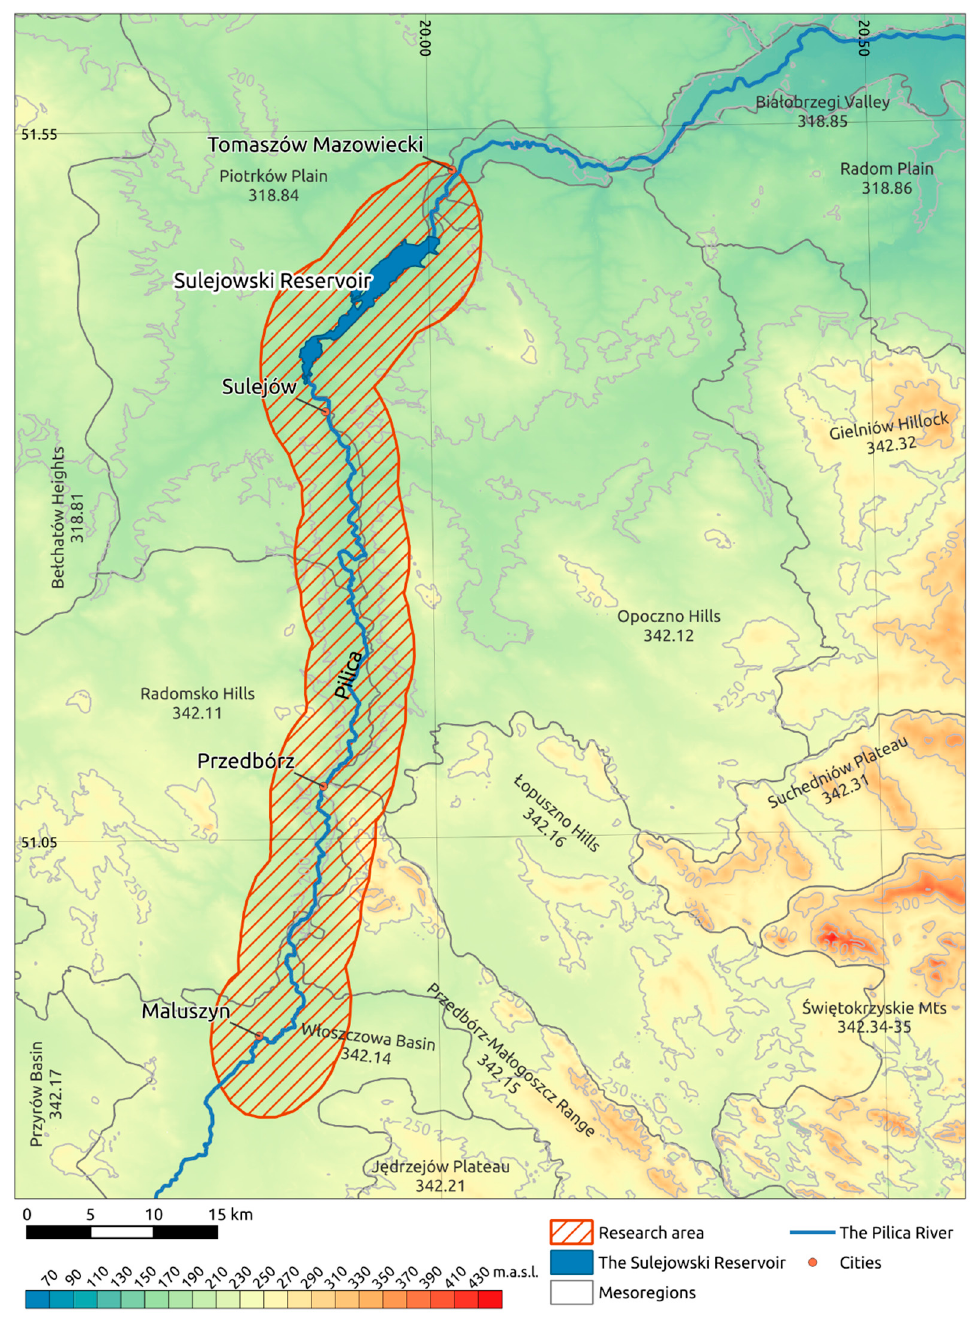
Figure 2. Research area, source: own elaboration based on physico-geographical regionalization of Poland [13] and Head Office of Geodesy and Cartography data [40]. Mesoregions codes are consistent with those introduced in the referenced paper and therefore enable precise localization of the research area within Polish mesoregions.